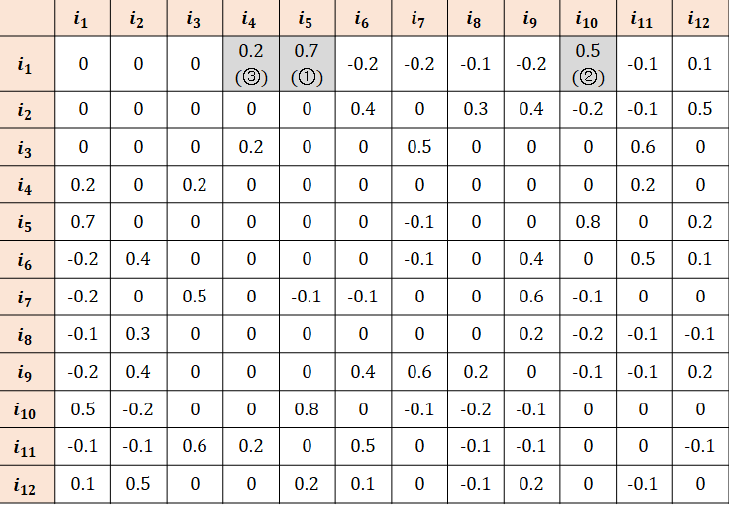
Figure 2. An example of item similarity matrix of k-RRI.